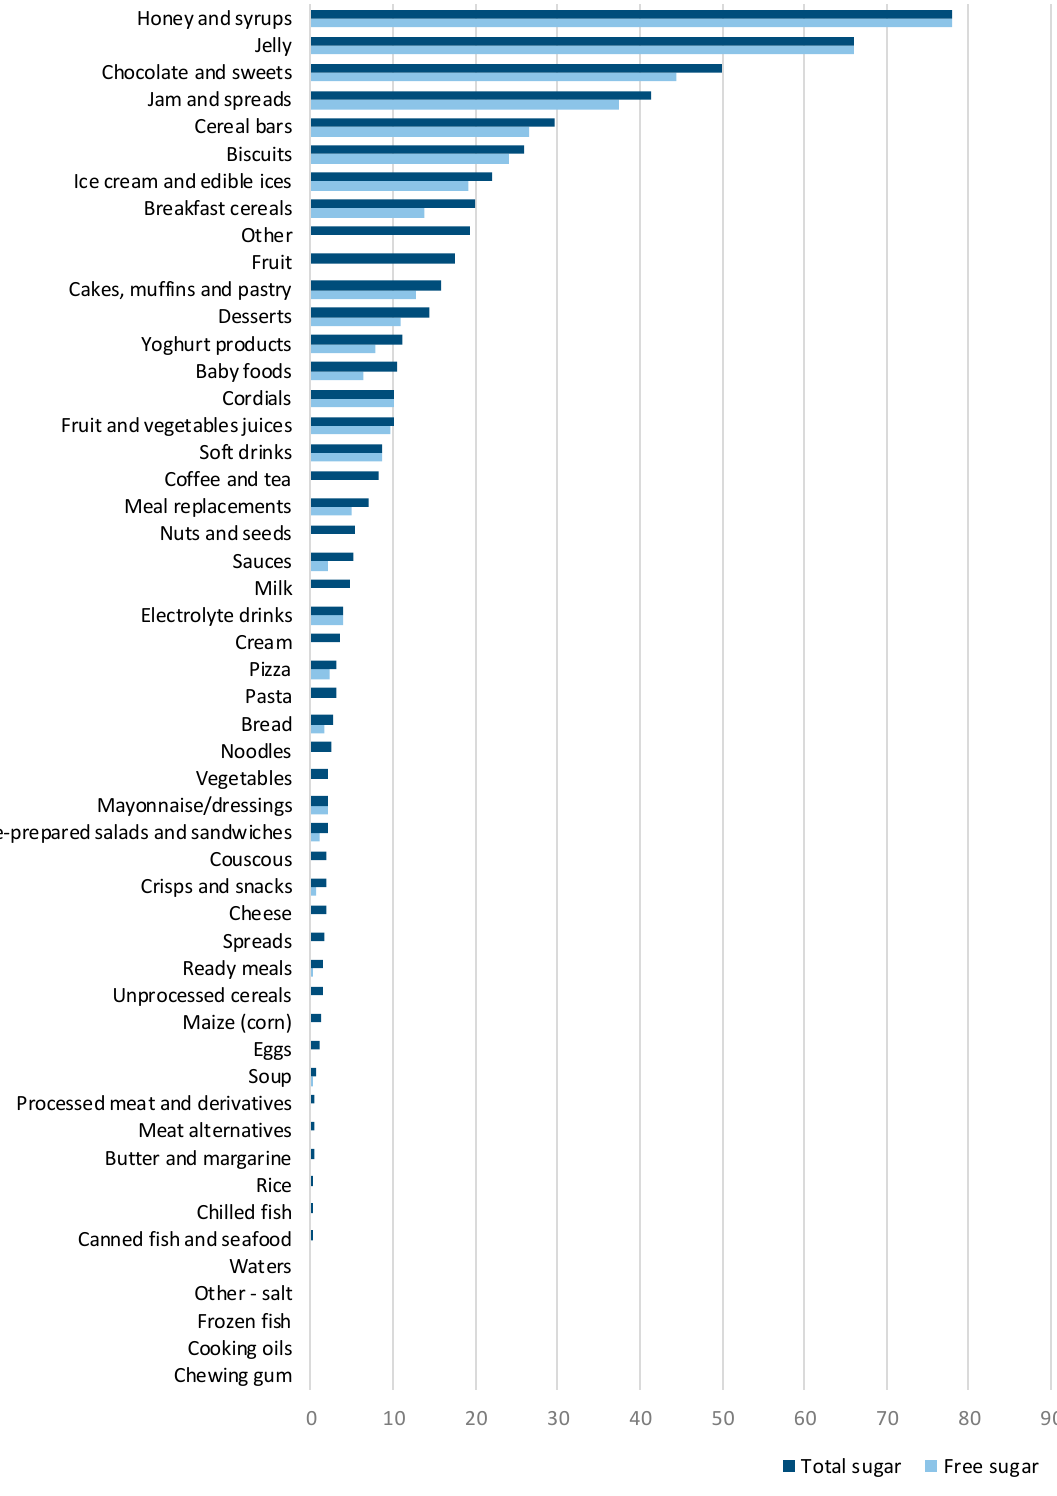
Figure 2. Median total and free sugar content (g/100 g or g/100 mL) per food category.